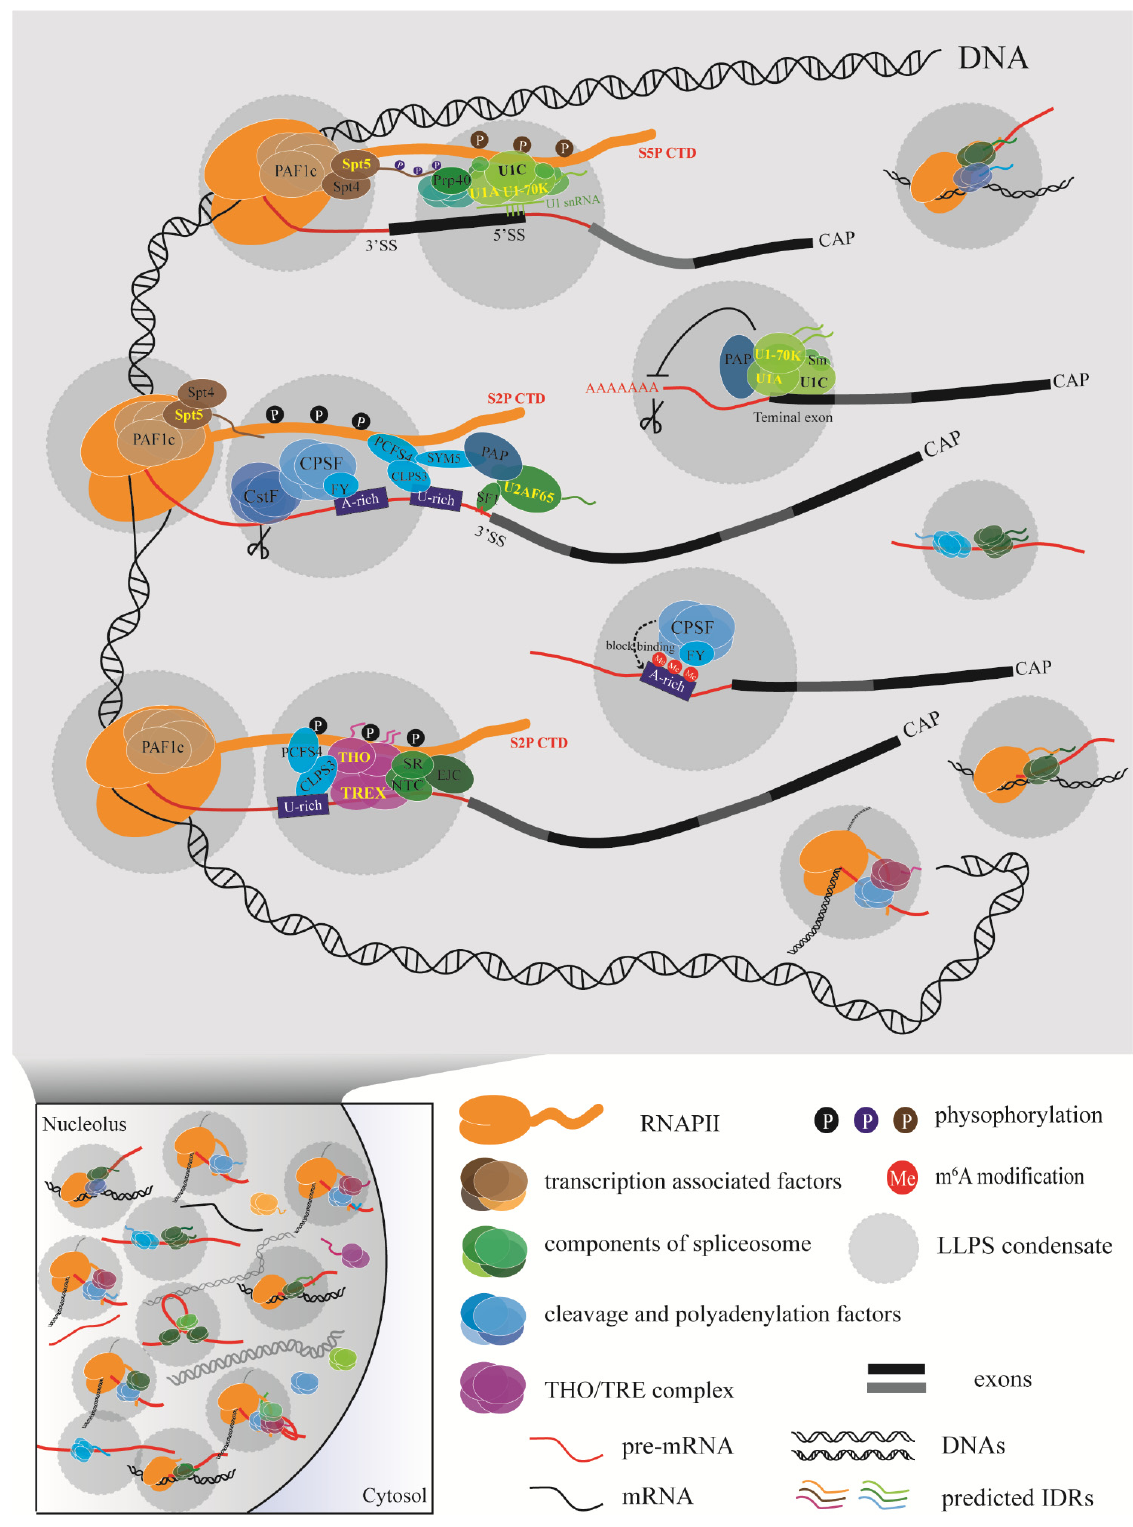
Figure 3. Schematic diagram of the coupling machinery generated through liquid–liquid phase separation (LLPS) in plants using different processing factors. The various regulatory processes are carried out efficiently inside the phase-separated condensate, which may be driven by the carboxy-terminal domain (CTD) of RNAPII or RNA processing factors with intrinsically disordered regions